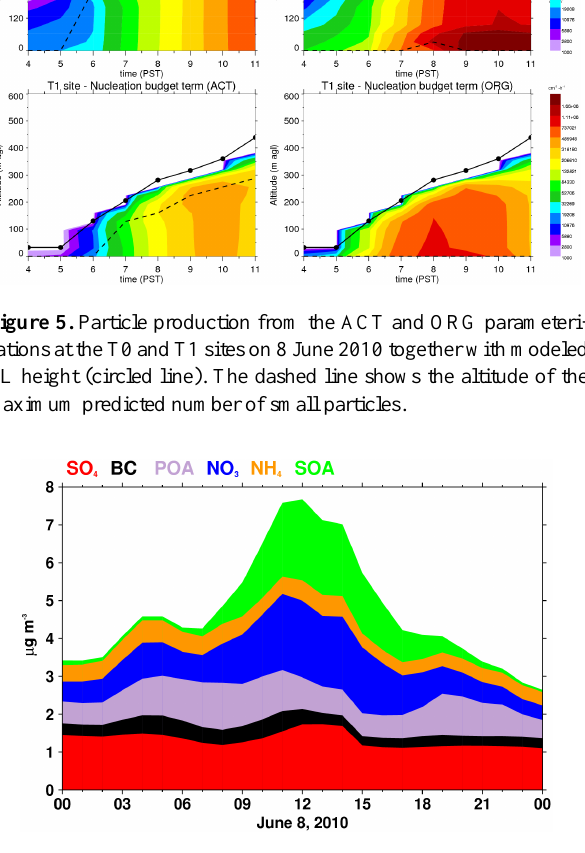
Figure 6. Simulated aerosol mass concentrations at the T0 site on 8 June 2010 predicted by the ACT